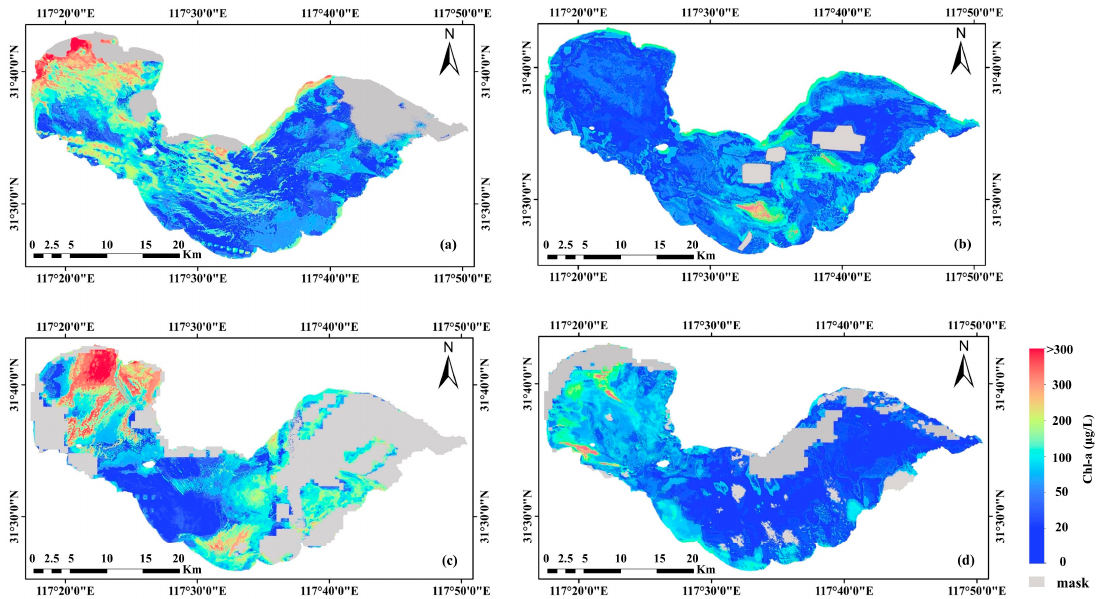
Figure 15. Spatiotemporal distribution of Chl-a across Lake Chaohu at four dates. ( a ) 2 August 2018; ( b ) 28 December 2019; ( c ) 25 June 2020; ( d ) 2 November 2020. The gray masks represent outliers due to cloud cover.